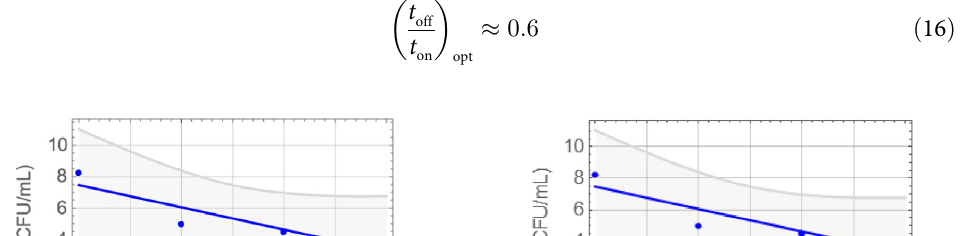
/ln(10), whereas the blue line slope (b) is K n ,off